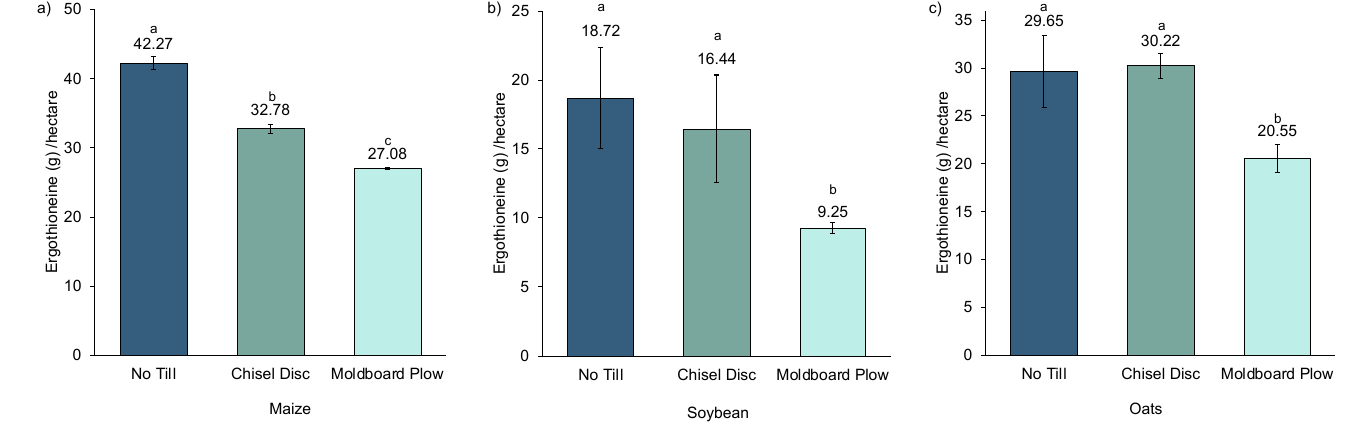
Figure 3. Ergothioneine production per hectare of crops ( a ) maize (2018), ( b ) soybean (2019), and ( c ) oats (2020) grown using different tillage methods; different letters above the bars indicate significant difference ( p > 0.05) within each crop type, error bars represent the standard deviation of each tillage type.